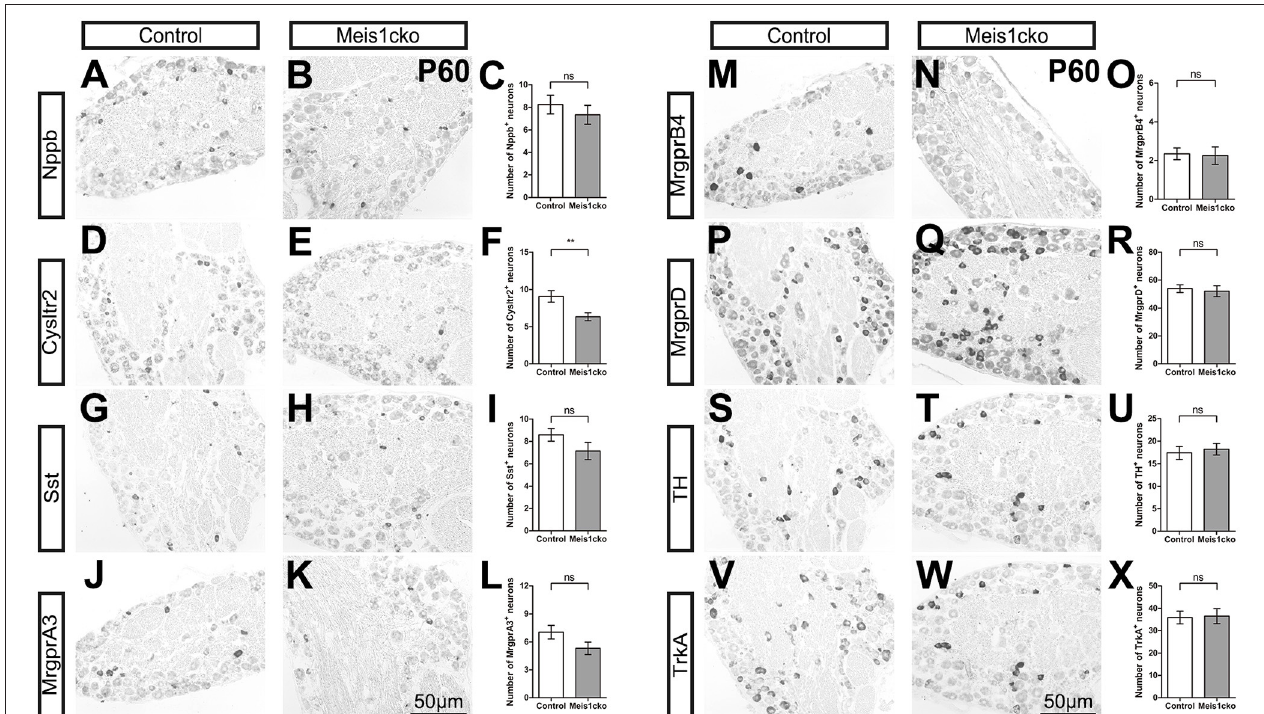
FIGURE 3 | Expression of a subset of known cluster-specific markers in Meis1cko and control lumbar DRGs. ISH with the indicated probes on L4 or L5 lumbar DRG sections from 3 pairs of P60 Meis1cko and control mice. (D–F) Cysltr2 expression were significantly decreased from 9.1 ± 0.8 in control DRGs to 6.3 ± 0.5 in Meis1cko DRGs, p = 0.008. (A–C) Nppb , (G–I) Sst , (J–L) MrgprA3 , (M–O) MrgprB4 , (P–R) MrgprD , (S–U) TH , and (V–X) TrkA expression. Error bars represent the SEM. Significant differences were determined using unpaired Student’s t -test: ** p < 0.01 ns, Not significant. Scale bar: 50 µ m.